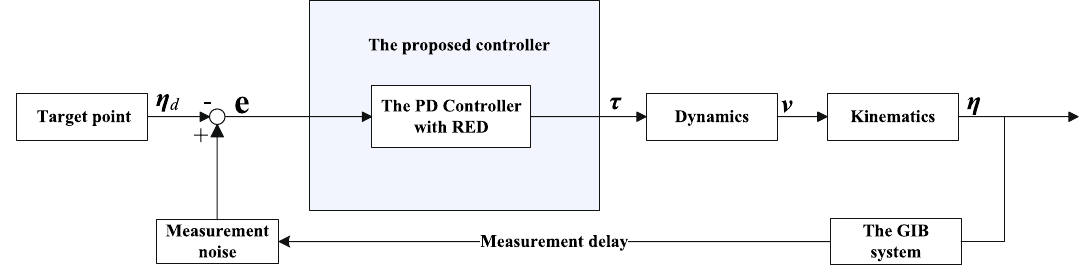
Fig. 4 Schematic diagram of the proposed tracking